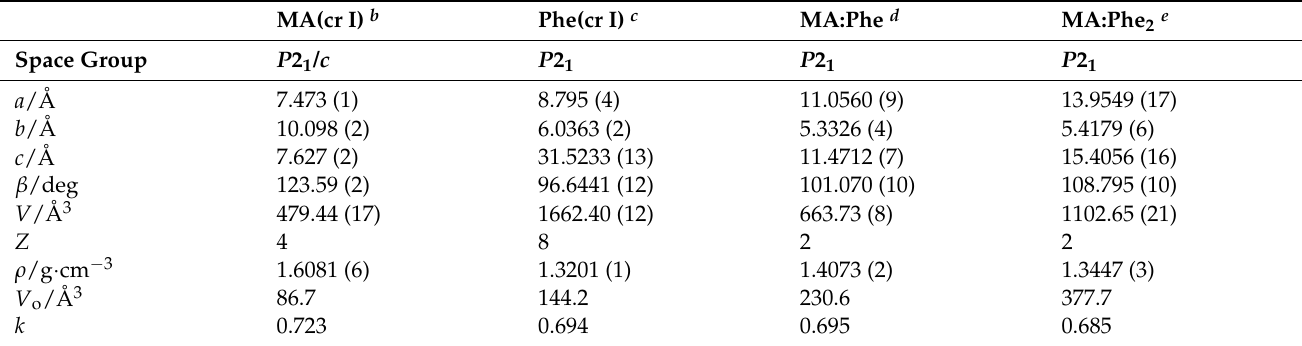
Figure 4. ( a ) The C 1 1 (7) chain 1D motif present in maleic acid packing and ( b ) the two 2 1 1 chains typical of L-phenylalanine packing. Table 1. Unit cell parameters, density ( ρ ), molecular volume ( V o ), and packing coefficient ( k = ZV o / V ) for the crystal forms studied in this work. a